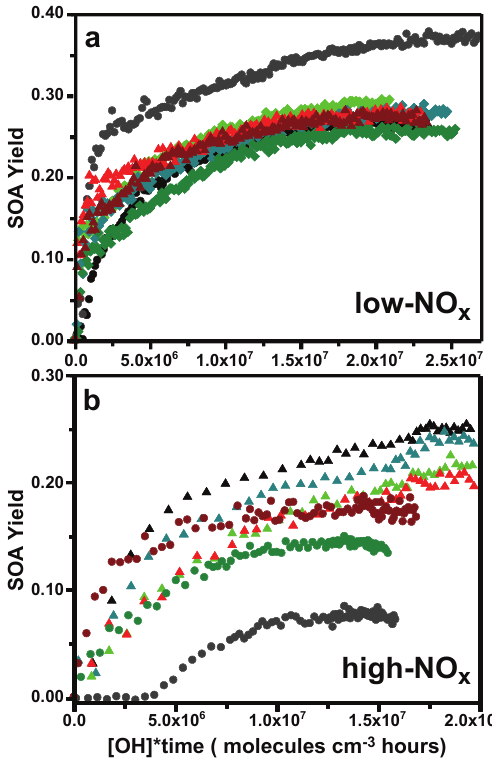
Fig. 3. SOA yield as a function of OH exposure of α -pinene OH ox- idation in the presence of no (black, gray), neutral (shades of green), or acidic (shades of red) seed particles under (a) low-NO x con- ditions and (b) high-NO x conditions where photolysis of HONO (dots) or methyl nitrite (triangles) is the OH source. The sam- ple IDs for each experiment are (a) black dots (1-H2O2), gray dots (7-H2O2), light green diamonds (3-H2O2), teal diamonds (9- H2O2), green diamonds (13-H2O2), red triangles (5-H2O2), dark red triangles (11-H2O2) (b) gray dots (2-HONO), black trian- gles (8-MeONO), green dots (4-HONO), light green triangles (10- MeONO), teal triangles (14-MeONO), dark red dots (6-HONO), and red triangles (12-MeONO). The low-NO x experiment that re- sulted in greater SOA yield (gray points in panel a (7-H2O2)) is from 20ppb of α -pinene, all other data is from the OH oxidation of ∼ 50ppb of α